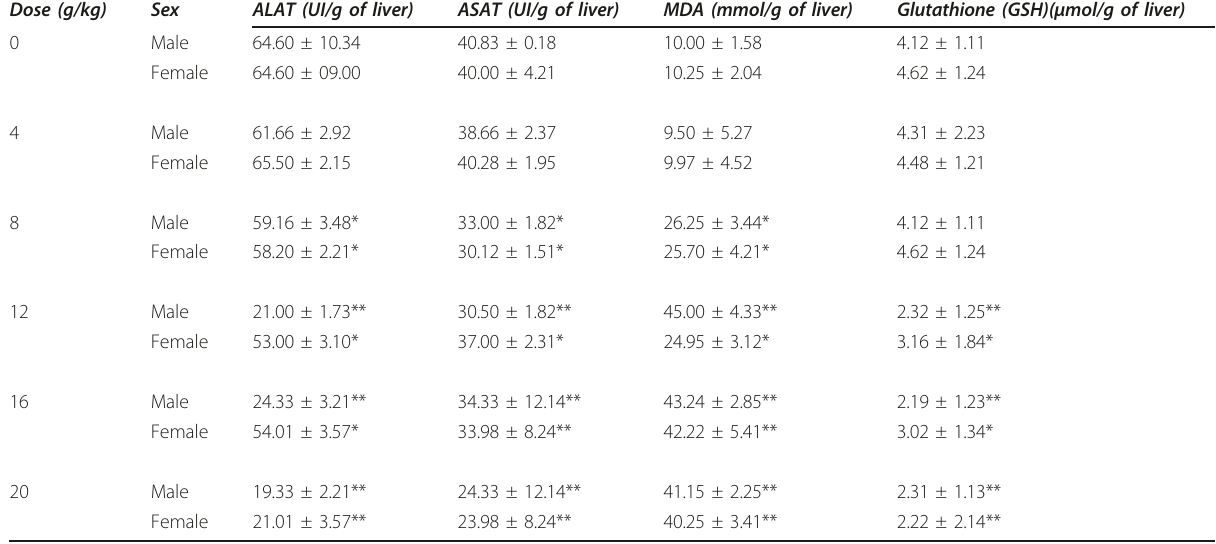
Table 5 Effect of the methanolic extract of Piptadeniastrum africana on different liver biochemical parameters of male and female rats Dose (g/kg)